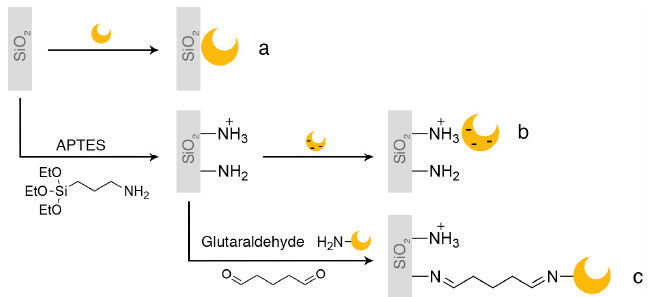
Figure 2. Immobilization methods: ( a ) simple adsorption; ( b ) adsorption assisted by electrostatic interactions; and ( c ) covalent grafting.